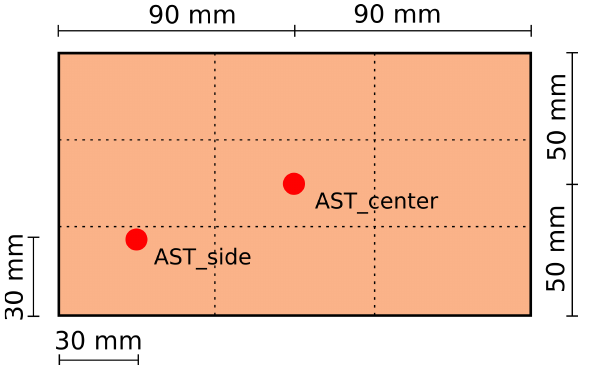
Figure 7. Position of the thermocouples on the ex- posed bottom surface. 3 3 FEM elements are indi- × cated.